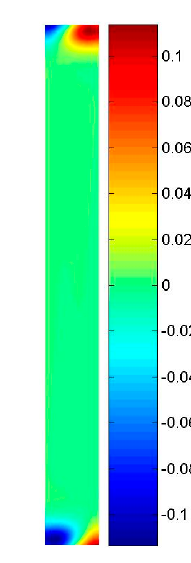
(e) Difference of temperature for (cid:1827) = 5 (f) Difference of temperature for (cid:1827) = 10 Figure 7. Temperature field ( a ) for (cid:1827) = 5 with the analytical solution; ( b ) for (cid:1827) = 5 with the Figure 7. Temperature field ( a ) for A = 5 with the analytical solution; ( b ) for A = 5 with the numerical numerical solution; ( c ) for (cid:1827) = 10 with the analytical solution; ( d ) for (cid:1827) = 10 with the numerical solution; ( c ) for A = 10 with the analytical solution; ( d ) for A = 10 with the numerical solution. solution. Difference between the analytical and numerical temperature distribution ( e ) for (cid:1827) = 5 and Di ff erence between the analytical and numerical temperature distribution ( e ) for A = 5 and ( f ) for ( f ) for (cid:1827) = 10 . A =